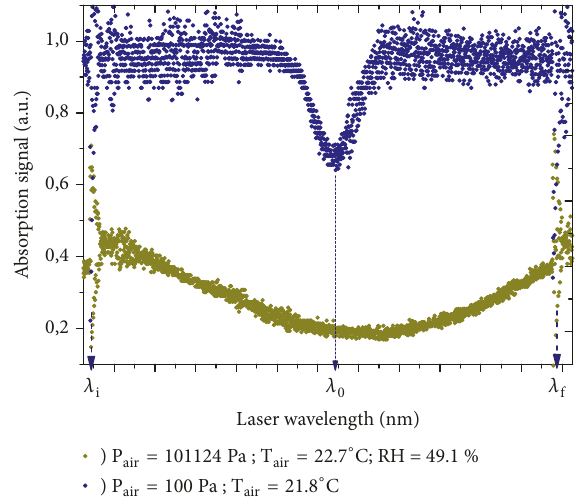
Figure 3: Absorption signal without laser background for the line at 1392.53 nm of H 2